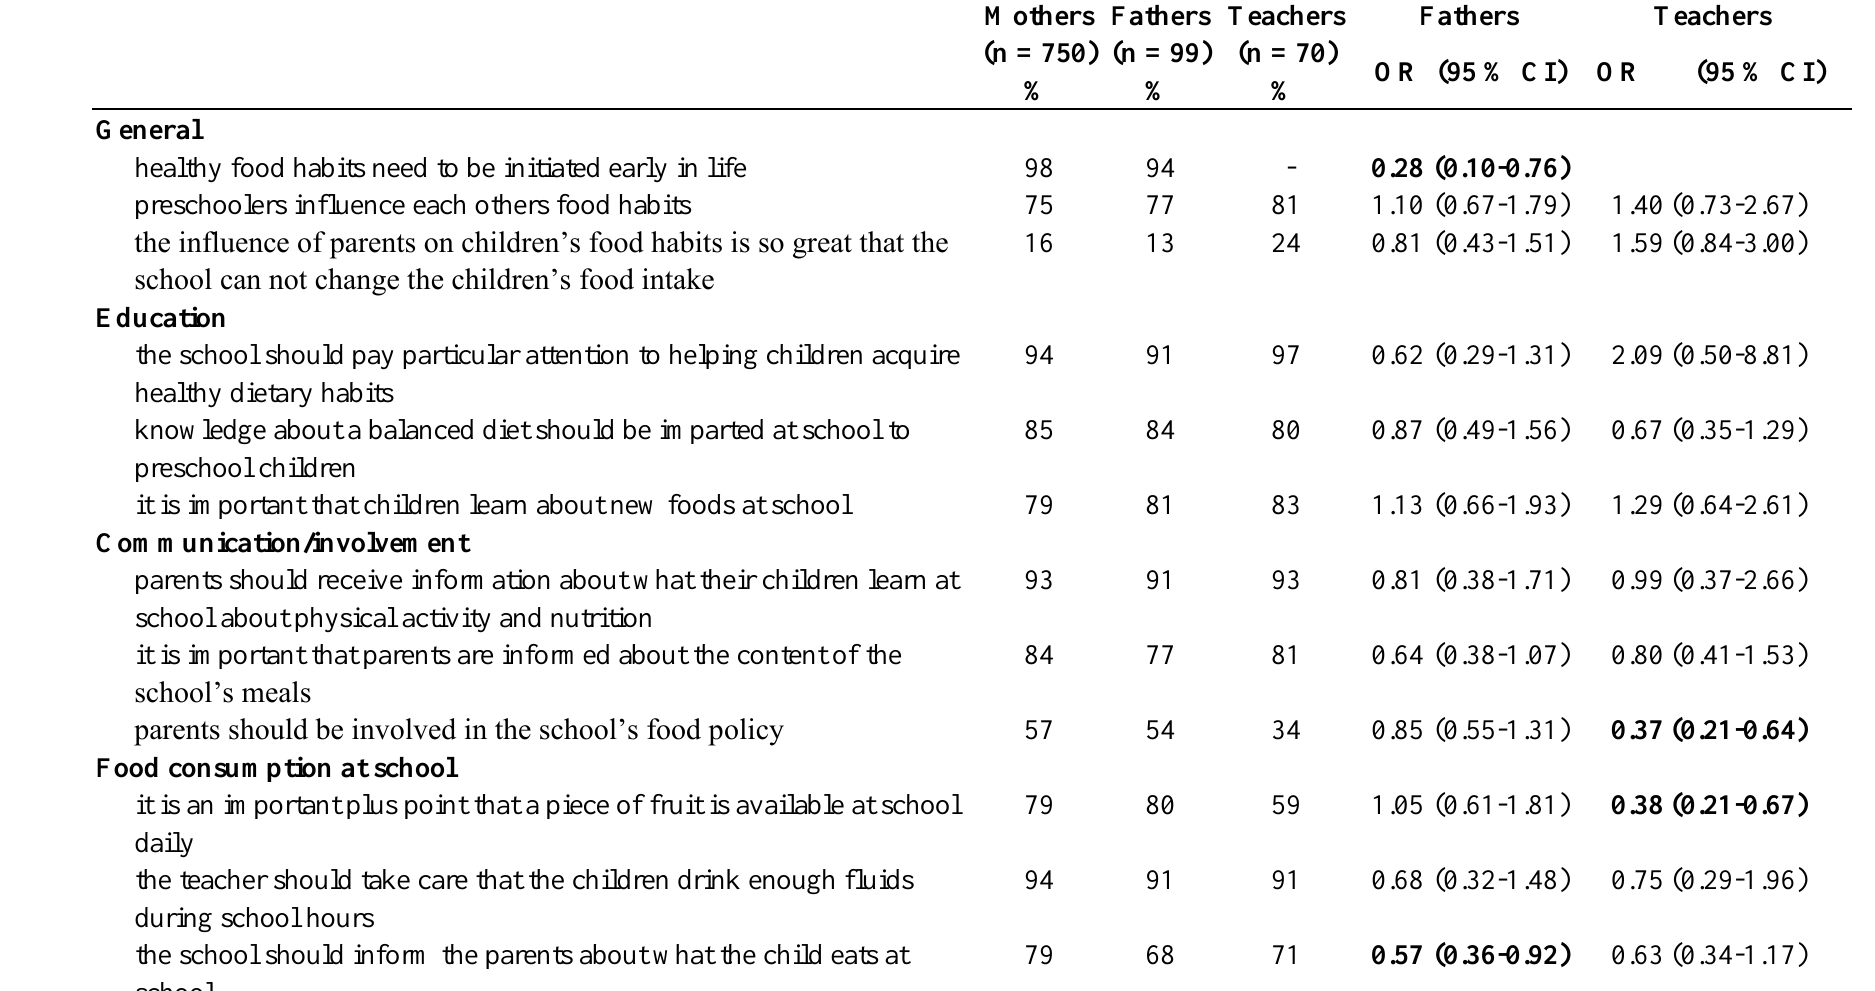
Table 2. Opinions and beliefs about the school food policy as reported by the parents and teachers of nursery schools, in Belgium Flanders: % agreeing and results of logistic regressions comparing mothers, fathers, and